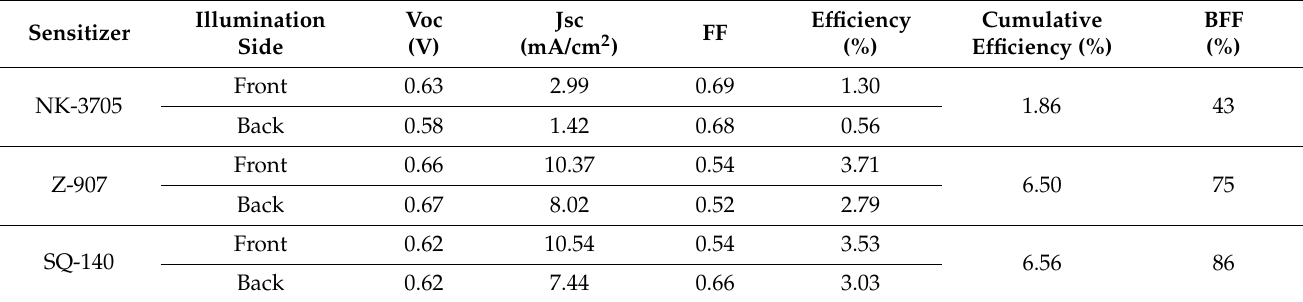
Figure 4. Photovoltaic characteristics of the BF-DSSCs based on TiO 2 photoanode fabricated utilizing different sensitizing dyes after front-side light irradiation. Corresponding dotted lines represent the J-V characteristics after light illumination from the rear side of the DSSCs. Table 2. Photovoltaic parameters of bifacial DSSCs using single-dye sensitizers after 1 Sun illumination from the front and rear sides of the BF-DSSCs.